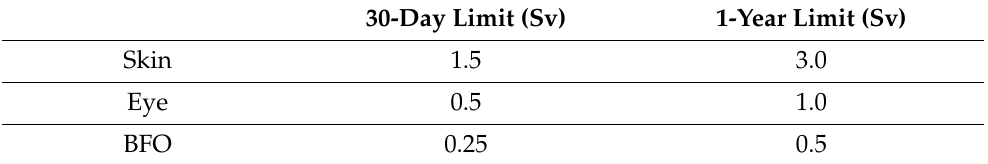
Table 4. ESA and RSA * limits for non-cancer effects [10].